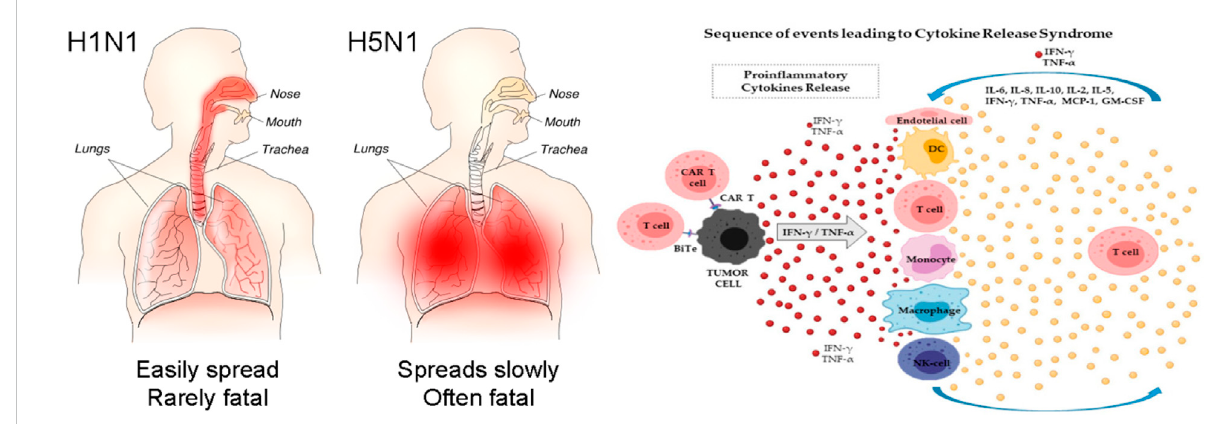
FIGURE 3 (Left)Severeviralinfection,acytokinestormdevelopsinthelungs(Author:TimVickers,Source:https://upload.wikimedia.org/wikipedia/commons/ b/b0/H1N1_versus_H5N1_pathology.png. (Right) The pathophysiology of cytokine storm (Adapted from Cosenza et al., 2021). (1)Viruses infect lung epithelial cells and alveolar macrophages, resulting in the production of cytokines /chemokines are produced by viruses infection (fundamentally have interferons). (2) Cytokines & chemokines that activate a macrophage and virally destroy dendritic cells initiate a cytokine storm, resulting in a more widespread immune response. (3) Chemokines released in the bloodstream attract more in fl ammatory cells to the irritation site, and these cells then release more in fl ammatory chemokines & cytokines, amplifying the “ cytokine storms ”